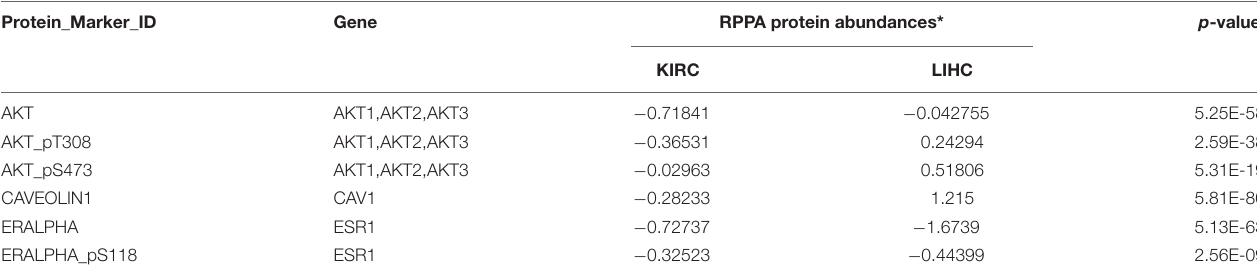
TABLE 1 | Different expression levels of selected protein between KIRC and LIHC using